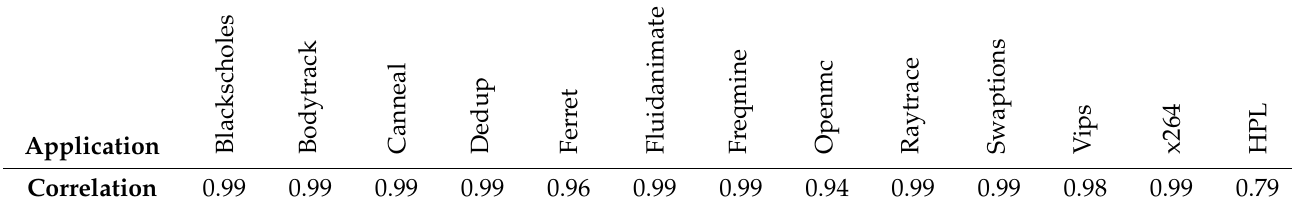
Figure 4. Relation between time and instructions for each input size. Table 2. Correlation of time and instructions for all applications.